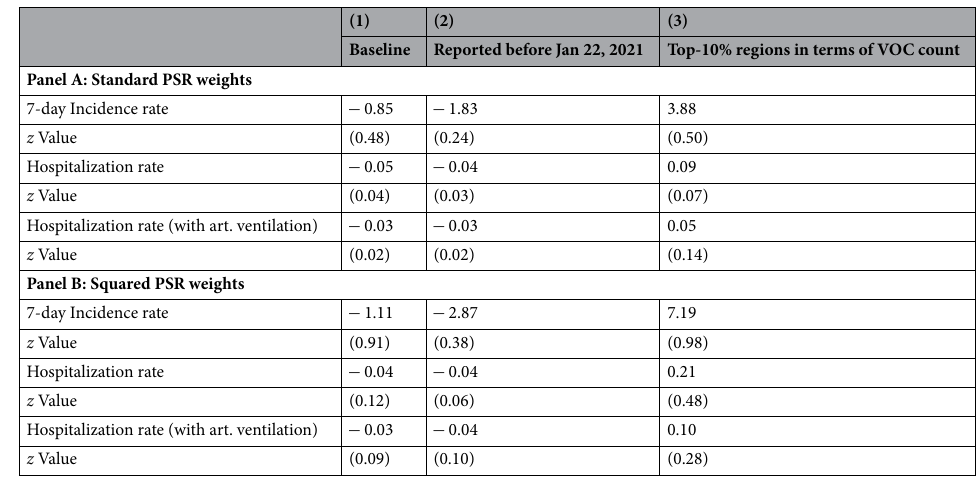
Table 3. VOC effect differences and tests for equality of regression coefficients between original near-time and weighted estimates using post-sampling ratio weights. Results report the difference in the estimated VOC β original β reweighted coefficients diff between the original near-time estimates reported in Tables 1 and 2 = − and the re-weighted specification using post-sampling ratio weights (and their squared values) for the 7-day (cid:30) (cid:31) incidence rate, the hospitalization rate (all patients in intensive care) and the hospitalization rate for patients with artificial ventilation. The reported z Values are the resulting test statistic from a z -test for coefficient equality across different regression models defined as z =